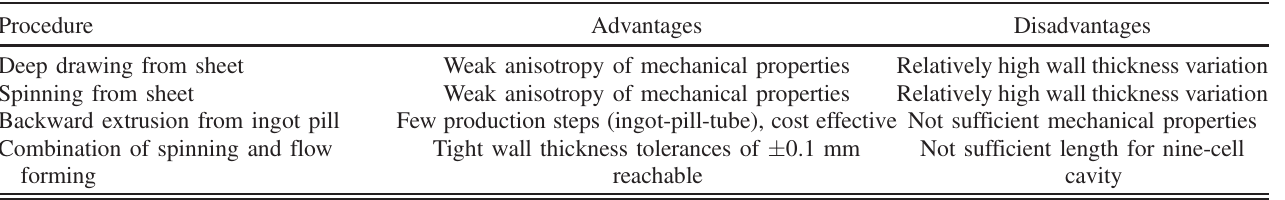
TABLE I. Comparison of acceptable methods of seamless tube fabrication. Procedure